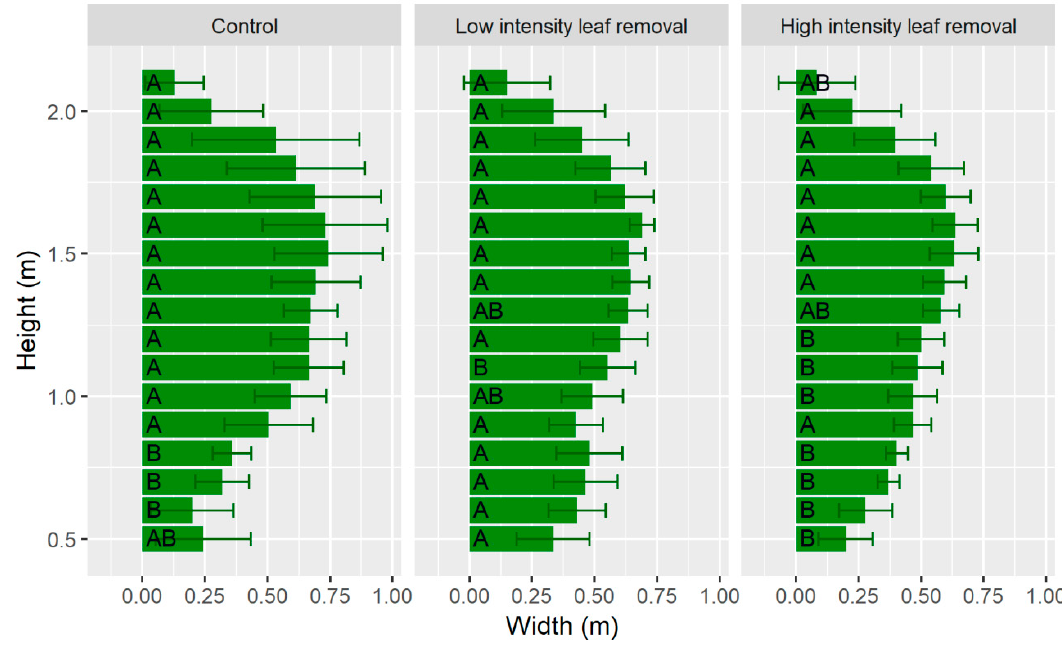
Figure 9. Vine width at different heights after the second leaf removal and trimming experiment at Ausejo-1 vineyard (error bars represent the standard deviation). For each height, different letters indicate significant differences among treatments at p = 0.05 by a Student’s T-test.